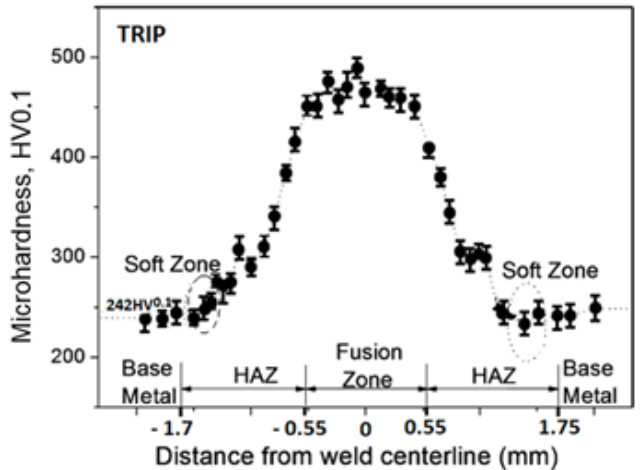
Figure 6. Weld microhardness profiles sample C (TRIP).